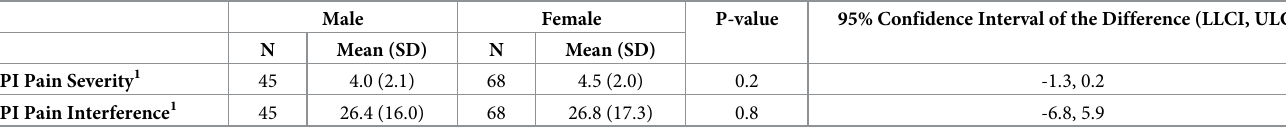
Table 2. Independent sample t-test.